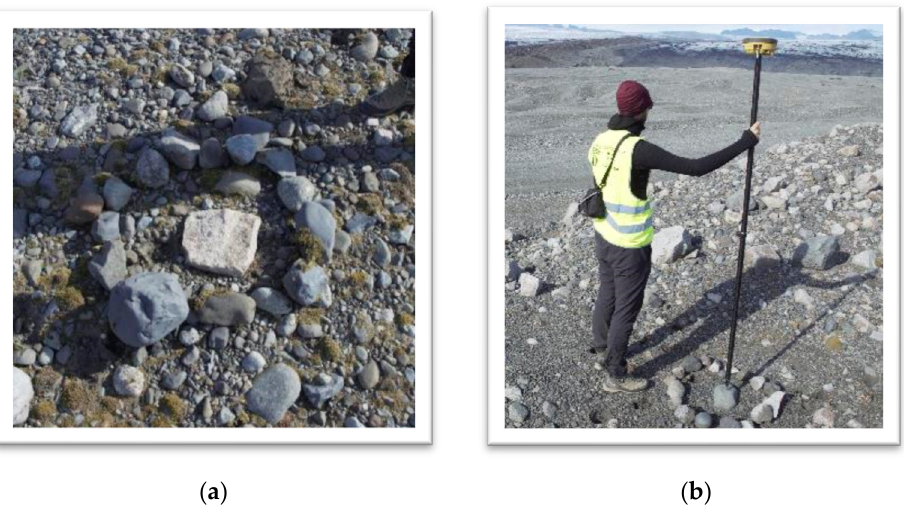
Figure 2. ( a ) Example of an established GCP; ( b ) method of measuring points with the GNSS receiver. GNSS measurement was carried out on the middle stone in the circle, which differed from the others by its size and shape.